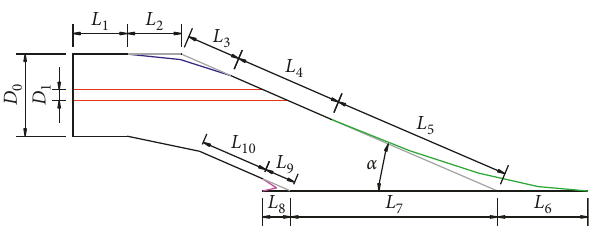
Figure 2: 2D structure sketch of inlet